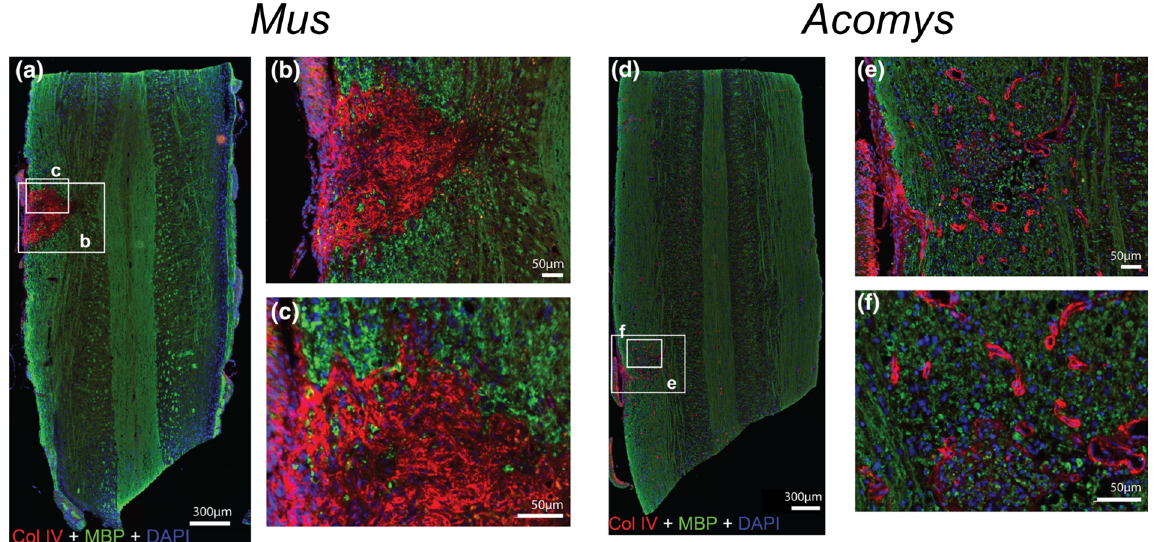
Fig. 3 Minimal fi brosis is observed in Acomys following spinal cord injury. Representative images of Mus ( a – c ) and Acomys ( d – f ) cervical spine, 4 weeks post-spinal cord injury. High magni fi cation images of the lesion epicenter show excess collagen IV deposition in Mus ( b , c ) in contrast to cell growth in Acomys ( e , f ). Scale bars in a and d = 300 µm and b , c , e , and f = 50 µm. ColIV = Collagen IV, labeled red; MBP = myelin basic protein, a marker for oligodendrocytes, labeled green; DAPI = nuclei, blue. Image reprinted from Streeter et al. 33 with permission.